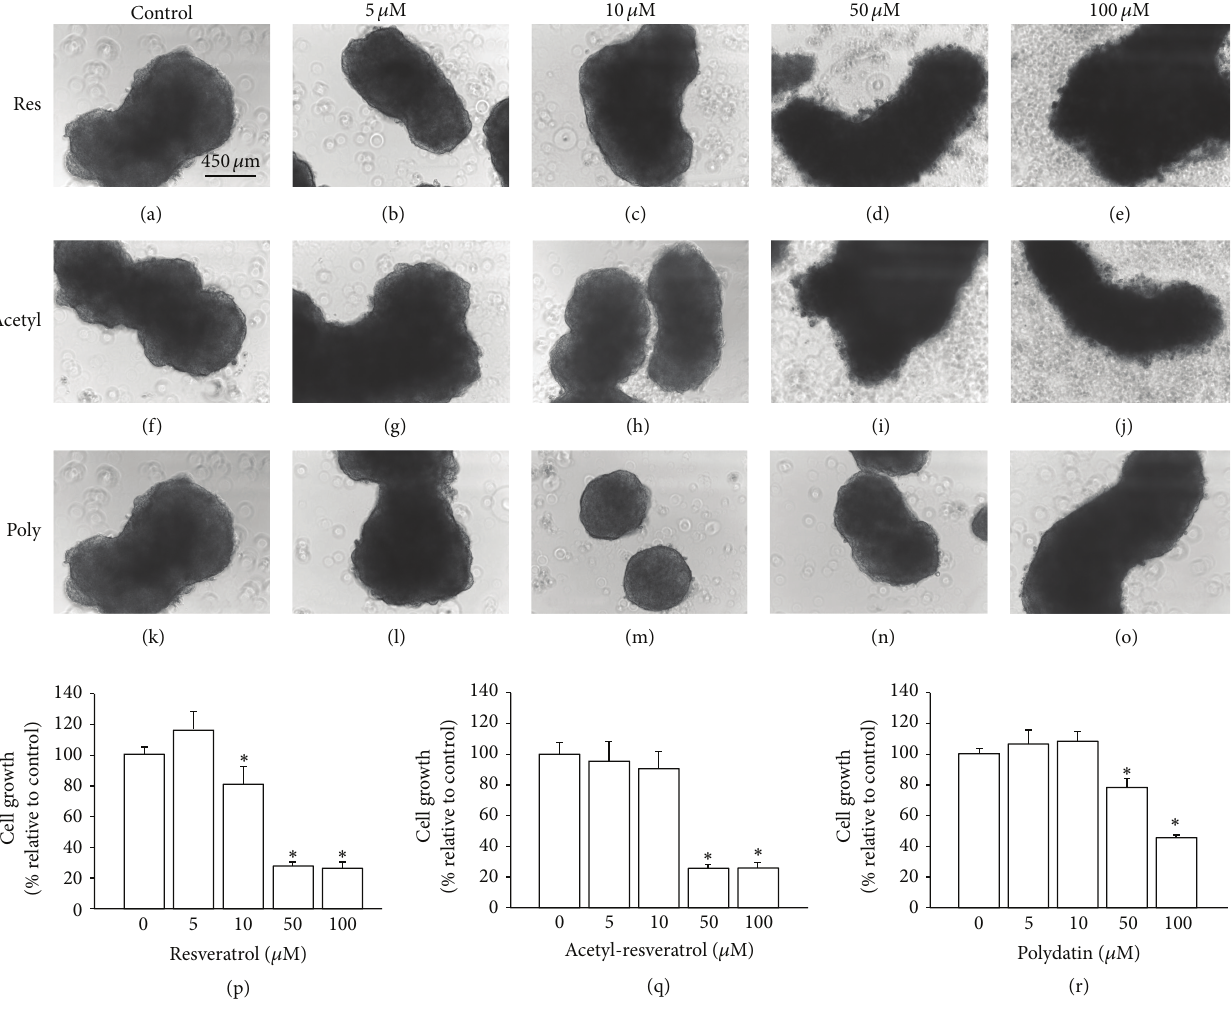
Figure 2: Morphological appearance of SKOV-3 cell aggregates with and without treatment. At higher concentrations all three compounds gave aggregates with irregular rims. The effect was more prominent with resveratrol (d, e) and acetyl-resveratrol (i, j) than with polydatin (n, o). The smooth rims of cell aggregates treated with lower concentration were not visibly different from those of control aggregates. Resveratrol significantly reduced cell growth at 10, 50, and 100 𝜇 M (p), but acetyl-resveratrol (q) and polydatin (r) only affected growth activity at higher concentrations. ∗ refers to statistically significant as 𝑝 value less than 0.05 compared to the